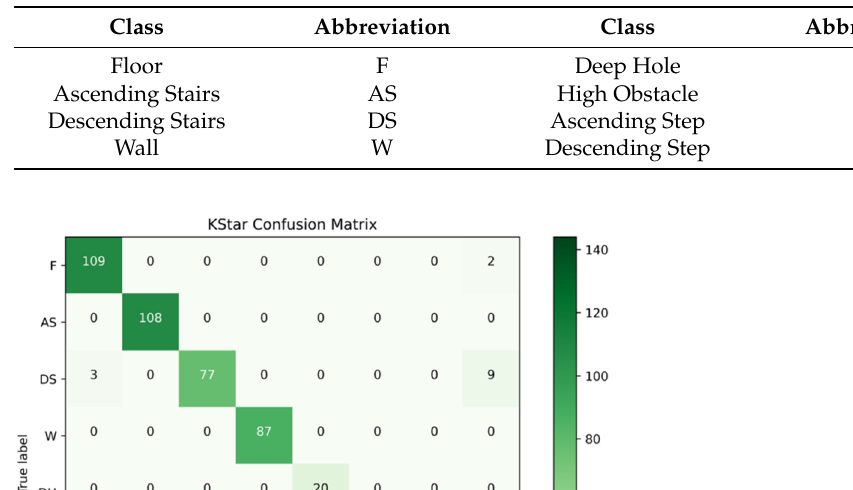
Table 12. Class Abbreviation.